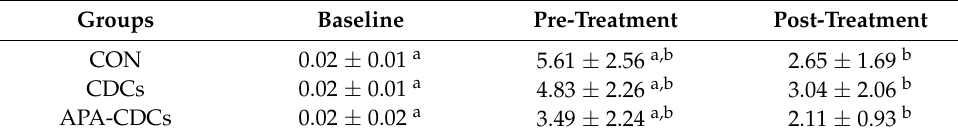
Table 1. Cardiac TnI values ( µ g/L) measured during the study.